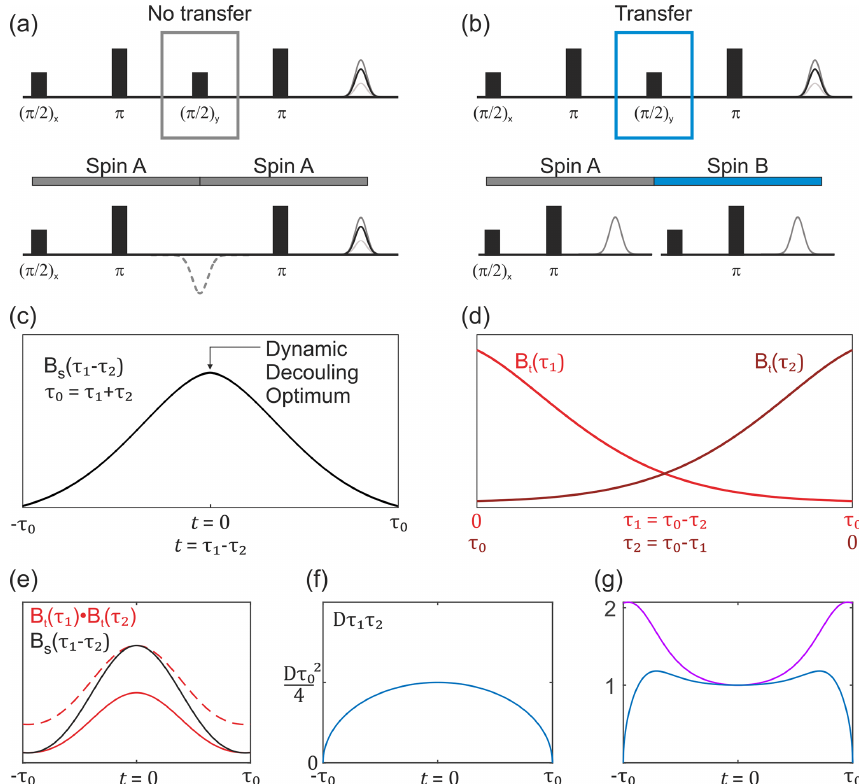
Figure 3. Overview of the buildup of the non-modulated part of the SIFTER signal. (a) SIDRE pulse sequence, which omits coherence transfer by the central ( π/ 2) y pulse. (b) SIFTER pulse sequence with coherence transfer. The two respective pulse sequence blocks show a difference in evolution with and without coherence transfer by the central ( π/ 2) y pulse. (c) Sketch of the SIDRE signal B S ( τ 1 ,τ 2 ) with the point of optimal dynamic decoupling indicated by the arrow. (d) Sketch of two variable-time Hahn echo traces, which are combined into the second type of background term, valid in the case of coherence transfer as shown in (b) . (e) Comparison sketch of the SIDRE signal (black), combination of two variable-time Hahn echo decays (solid red line) and the double-Hahn echo decay signal rescaled to the same amplitude as the SIDRE signal at the time point t = 0 (dashed red line). (f) Intermolecular coherence transfer factor Dτ 1 τ 2 as a function of the SIFTER time t . (g) Sketch of the divided trace B t ( τ 1 ) B t ( τ 2 ) /B S ( τ 1 ,τ 2 ) (violet) and this signal multiplied by the intermolecular coherence transfer factor Dτ 1 τ 2 (blue). Note that τ 0 = τ 1 + τ 2 , and for the SIFTER time t = τ 1 − τ 2